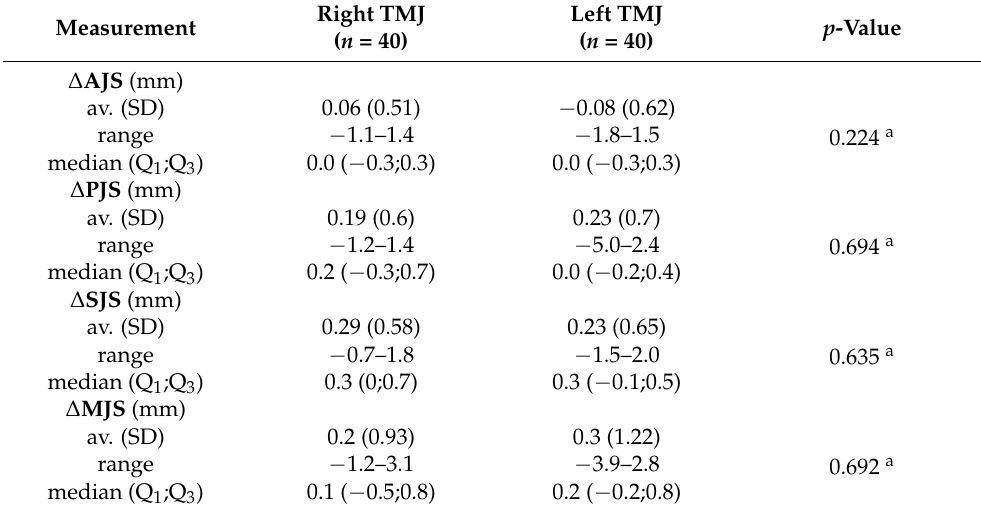
Table 8. The average changes in the values of different joint spaces after the end of the treatment in right and left TMJs in the study group.